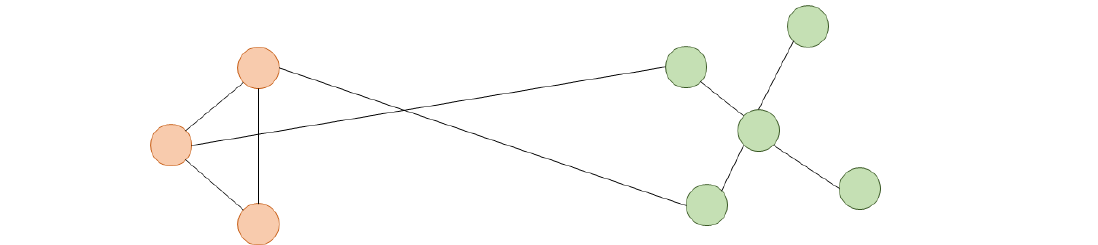
Figure 3. An example of Blockmodel likelihood calculation Here, a probable partitioning is presented. The block on left is α and the block on right is β . Q ∗ αα = 1, Q ∗ is calculated, as follows: 1 3 × 1 × 2